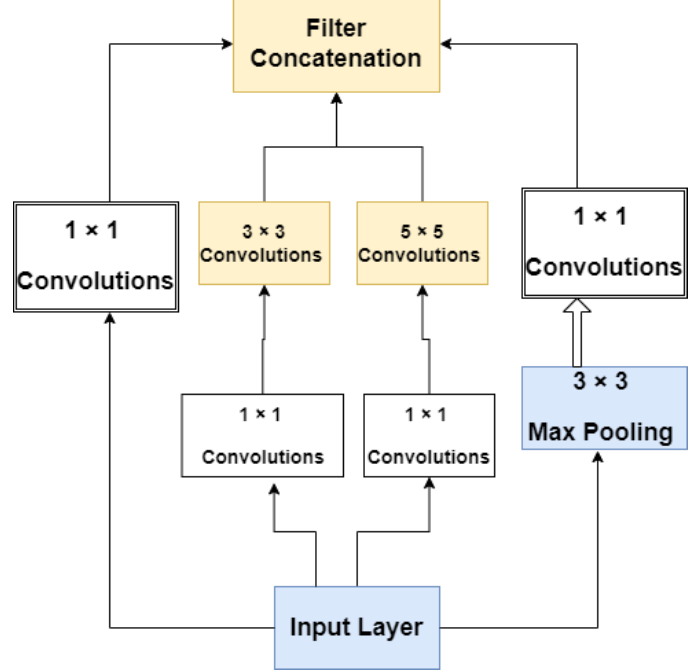
Figure 2. The model of GoogleNet’s structure